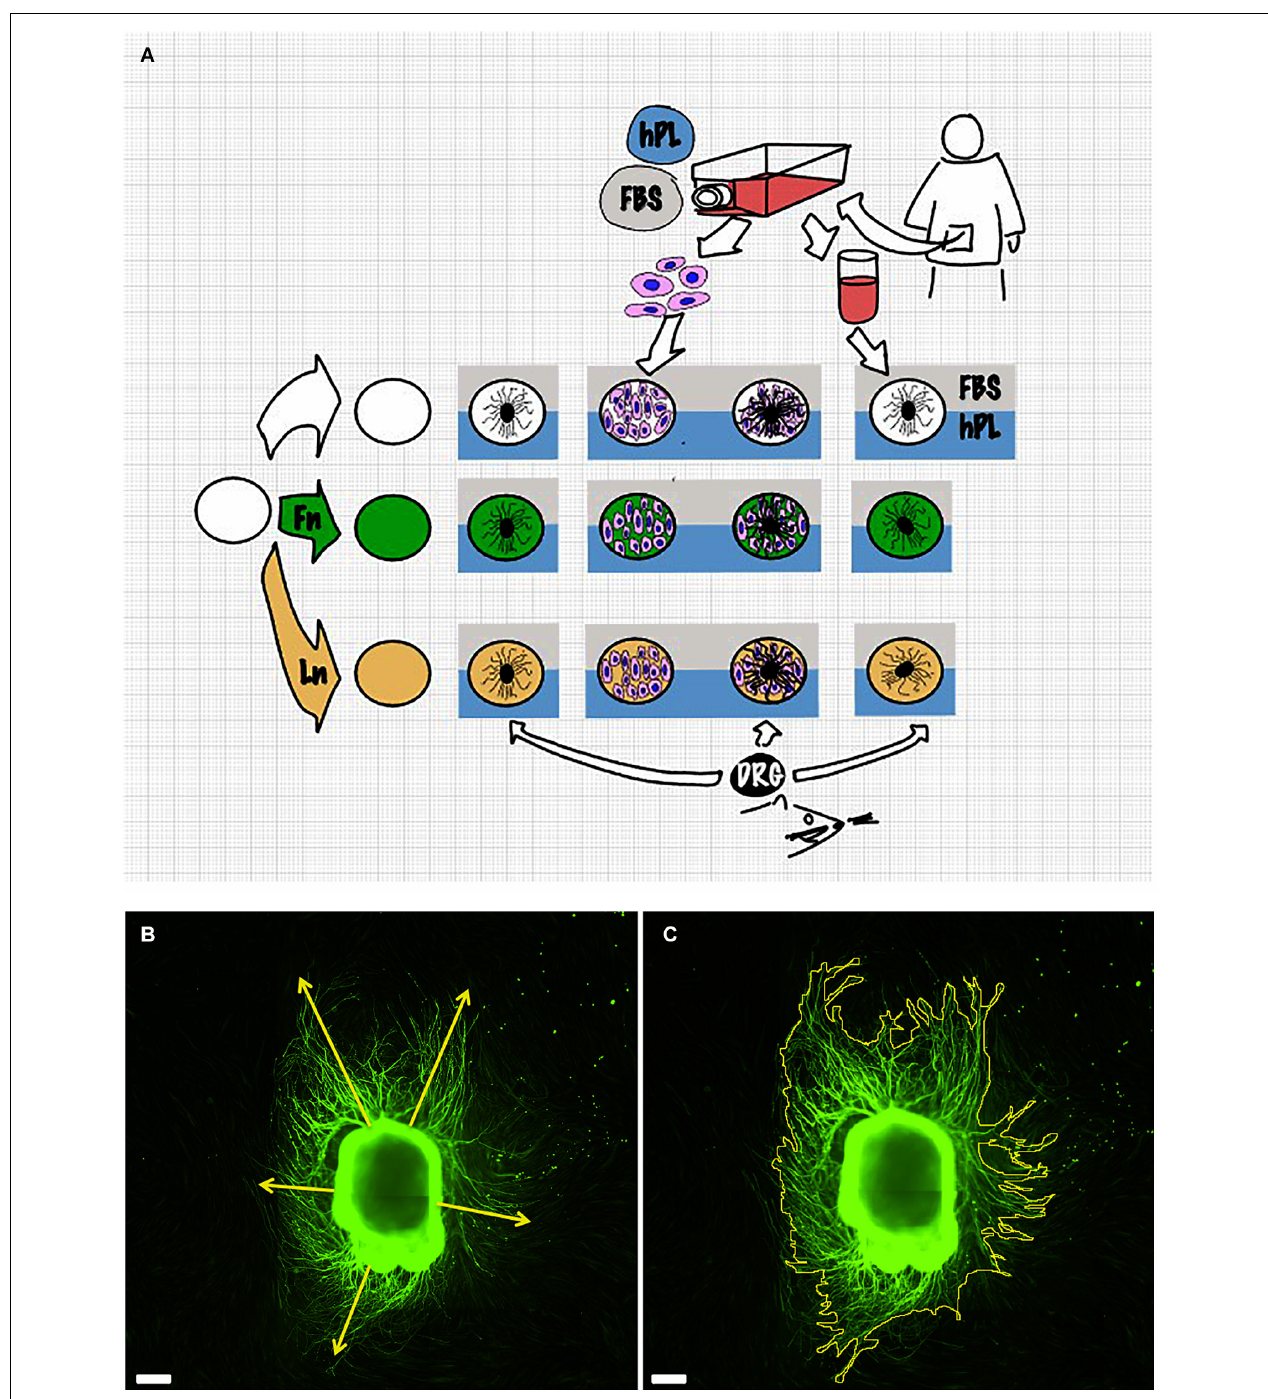
FIGURE 1 | Scheme of the experimental setup (A) . Details of the measurement method: dorsal root ganglion (DRG) longest neurite (B) and area (C) . Scale bar: 500 µ m.